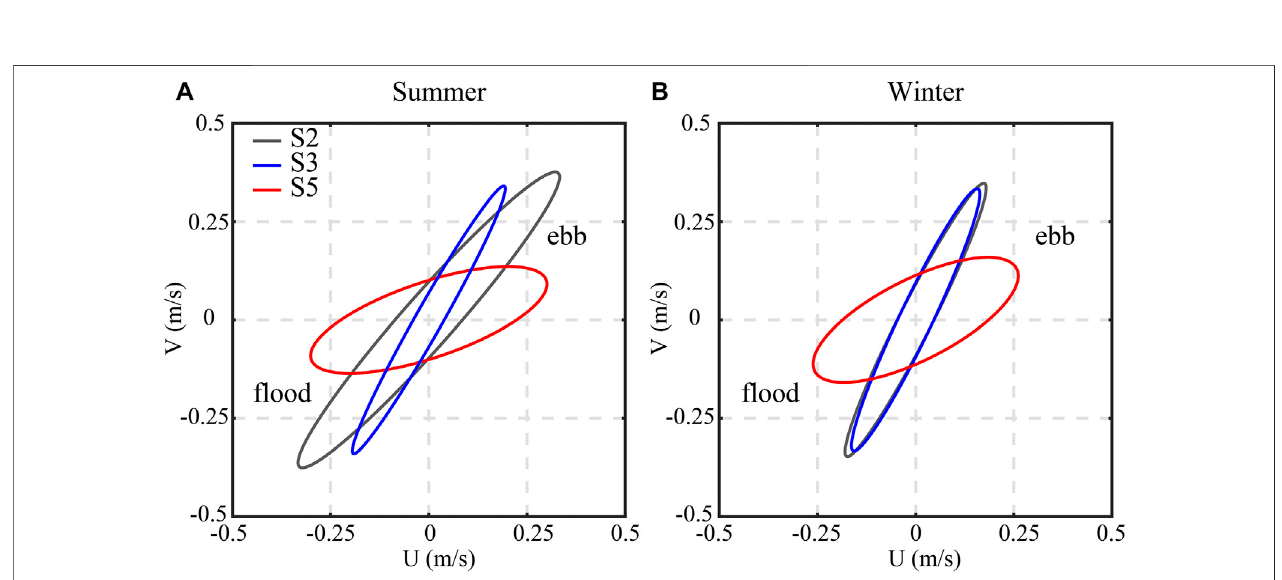
FIGURE 3 | Tidal ellipses of M 2 tidal components were calculated from the mean velocity at 1 mab in (A) summer and (B) winter for each of the three stations. The mean velocity was translated from ADV data by log law.